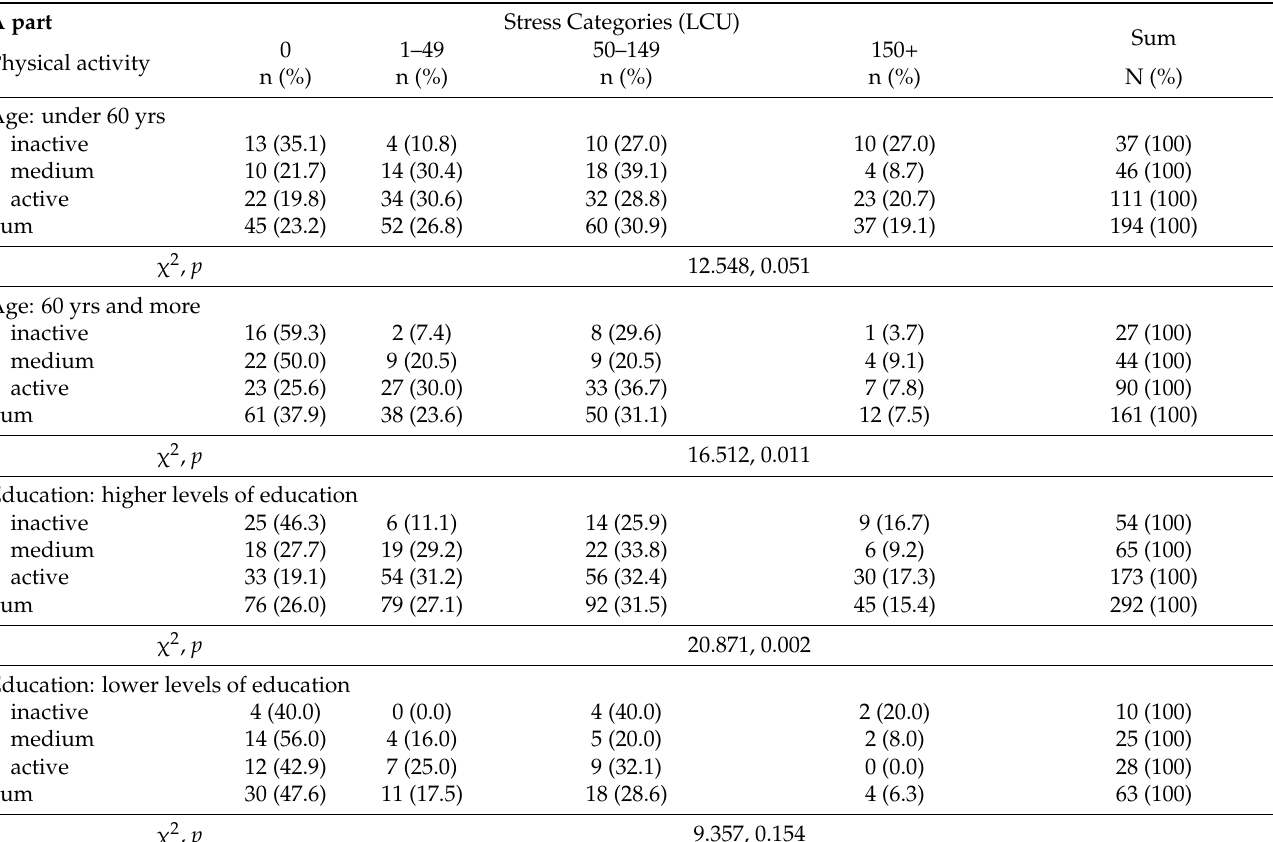
Table 2. Associations of level of physical education and stress (with age and education control): Part A—number of observations ( n ) and proportions (%) of stress categories by age and physical activity level and results of χ 2 and p ; Part B—results of the Mann–Whitney U test for stress by age and physical activity